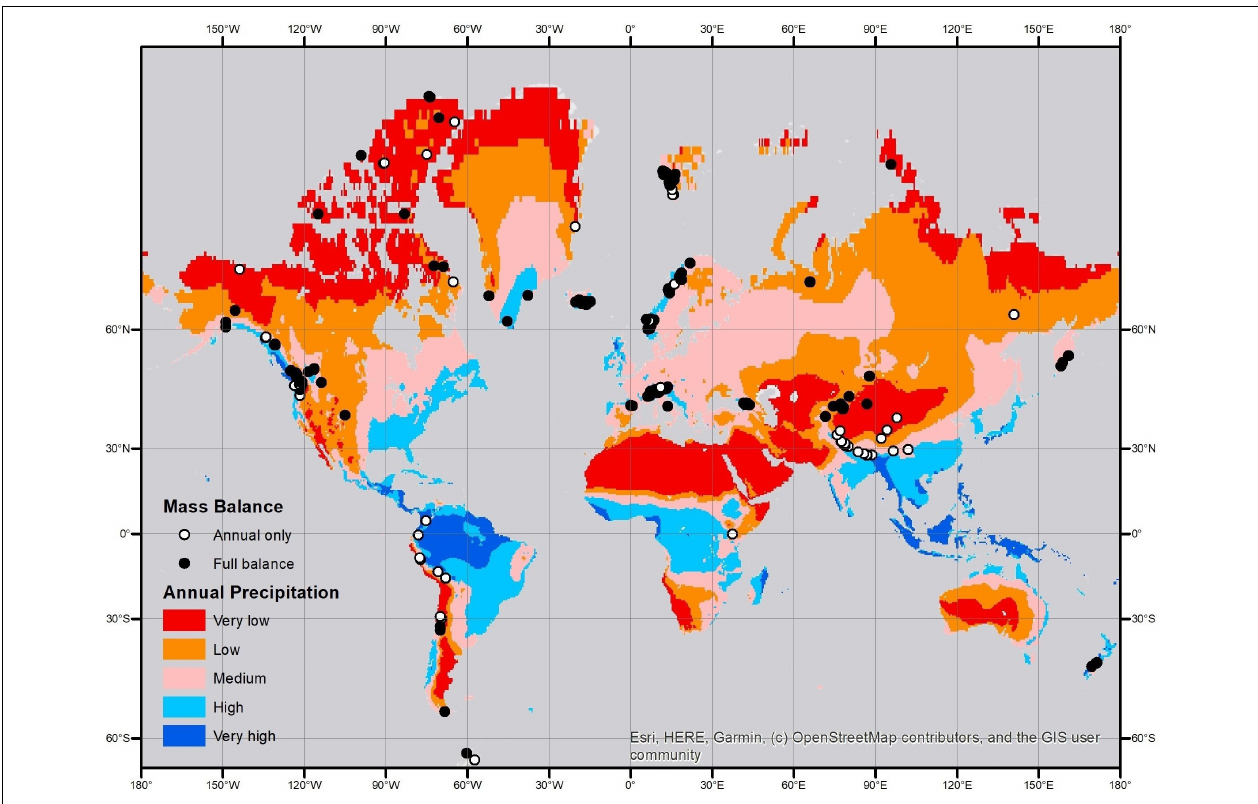
FIGURE 3 | Locations of mass balance studies > 4 years of record for 1946–2015 plotted onto the global distribution of annual precipitation according to the Climatic Research Unit (CRU)/University of East Anglia (UEA) gridded climatology (New et al., 1999).